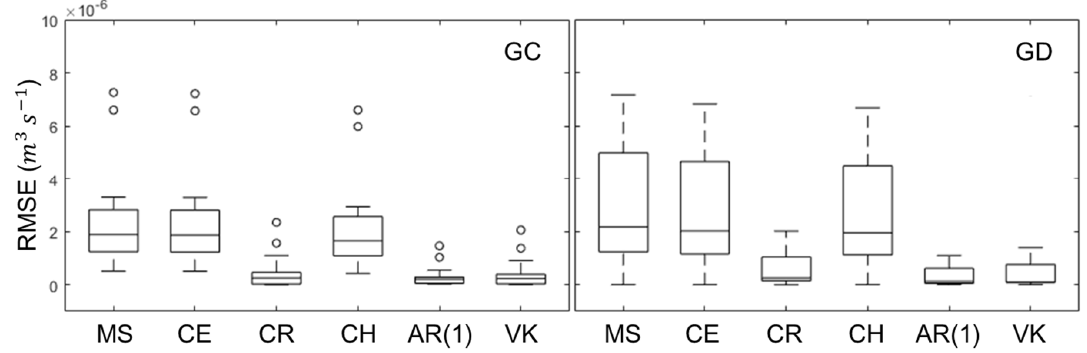
Figure 6. Root mean square error (RMSE) of the six methods in the GC and GD